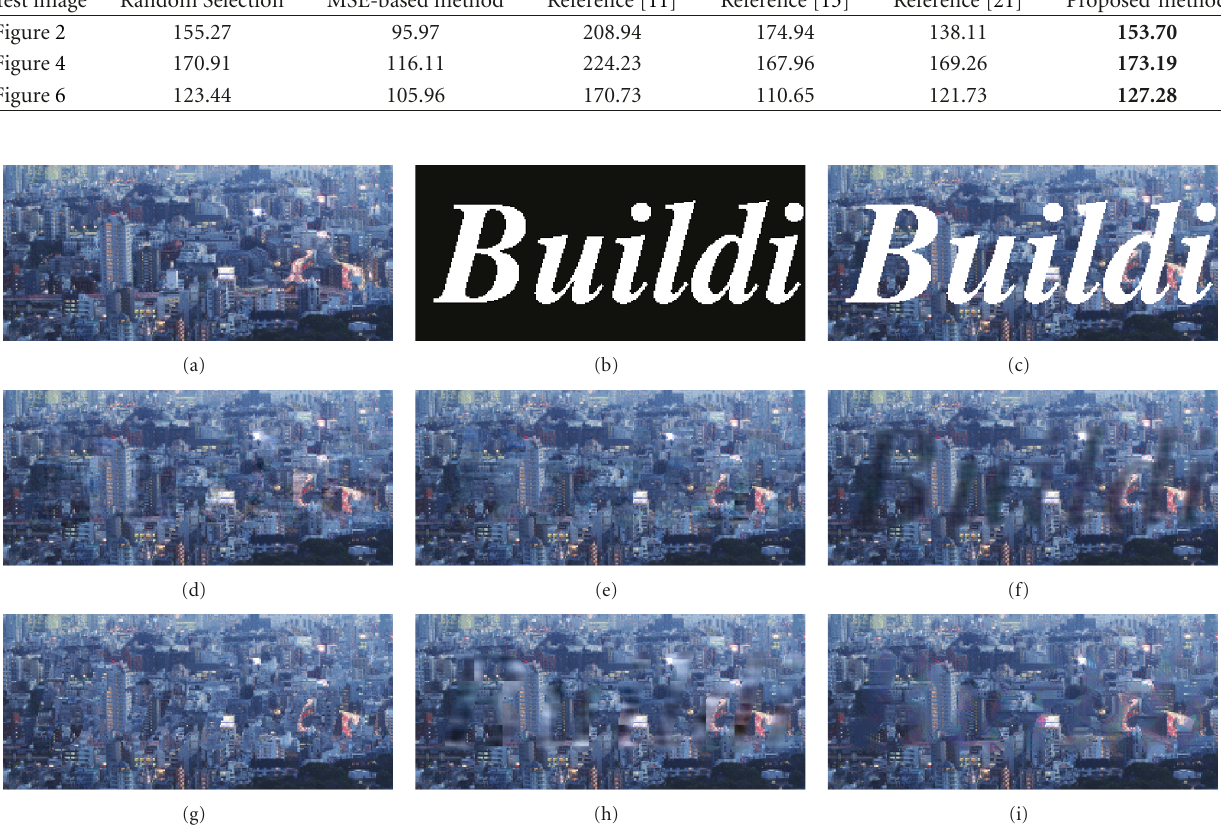
Figure 5: (a) Zoomed portion of Figure 4(a). (b) Zoomed portion of Figure 4(b). (c) Zoomed portion of Figure 4(c). (d) Zoomed portion of Figure 4(d). (e) Zoomed portion of Figure 4(e). (f) Zoomed portion of Figure 4(f). (g) Zoomed portion of Figure 4(g). (h) Zoomed portion of Figure 4(h). (i) Zoomed portion of Figure